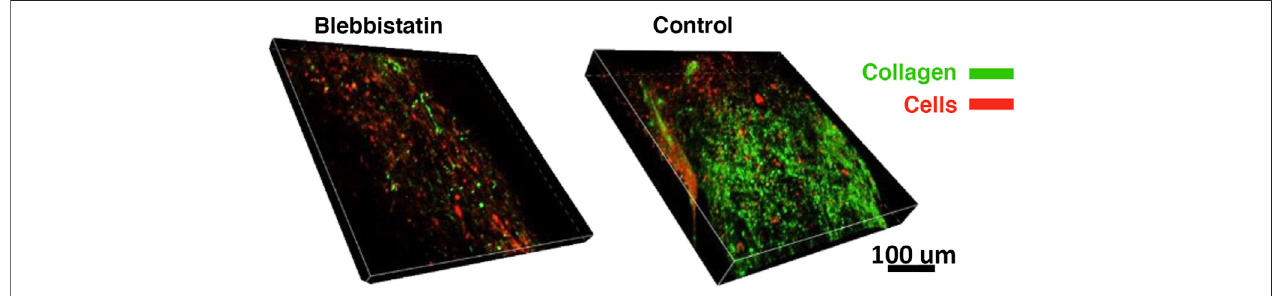
FIGURE 7 | Differences in collagen synthesis visualized on day 6. Collagen deposition (green) and cells (red) depicted in the confocal volume rendering for blebbistatin and control (i.e., no treatment), respectively.